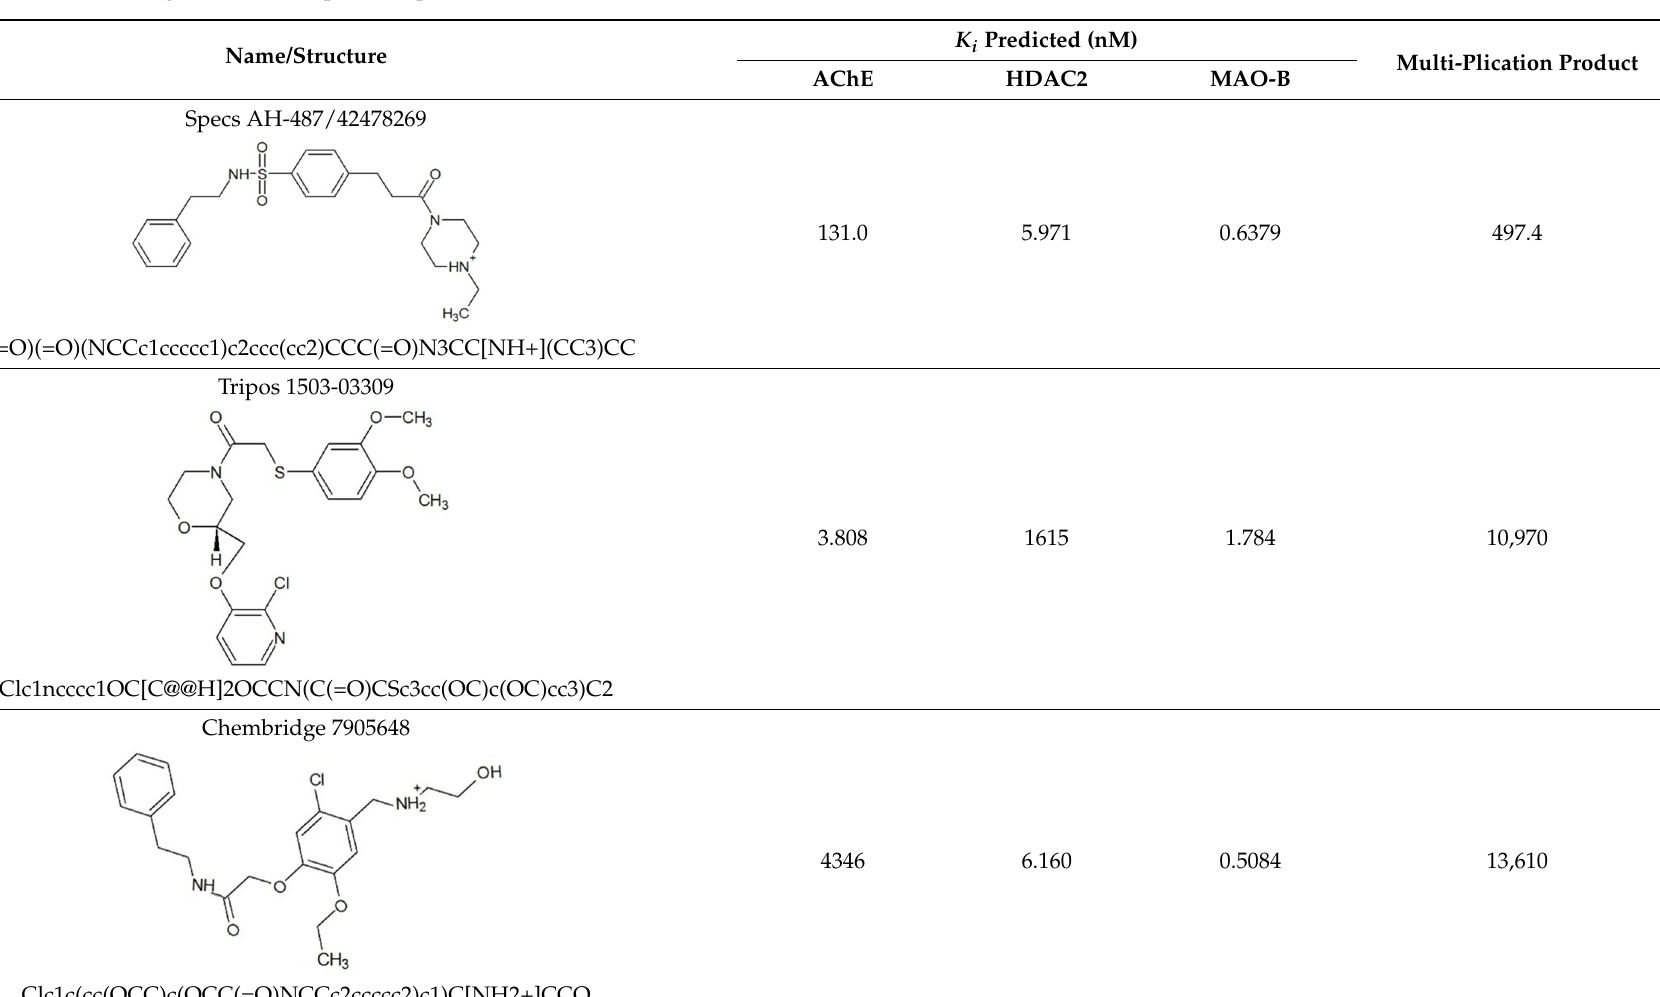
Table 3. Selected hits with their names, structures (incl. SMILES), affinity values (predicted K i , nM) and affinities’ multiplication product. Compounds are ranked according to the K i multiplication product.